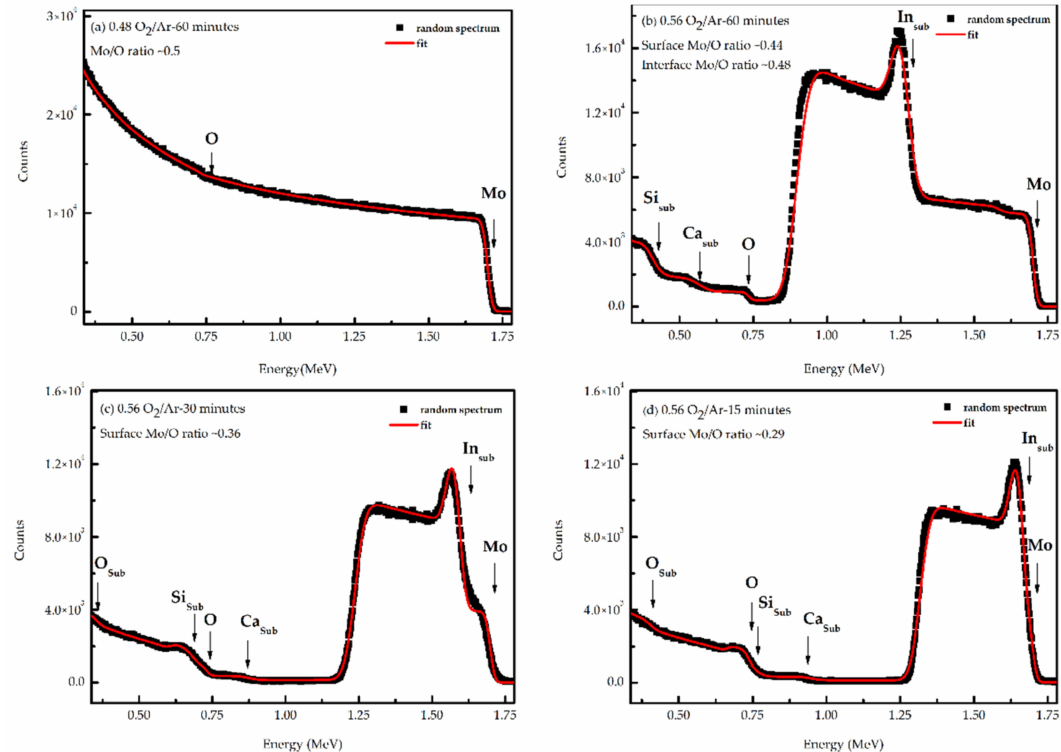
Figure 2. Rutherford Backscattering Spectrometry (RBS) spectrum obtained for measurements of the last sample from the first series: ( a ) deposited with a flow rate ratio of 0.48 O 2 /Ar for 60 min; and of the samples of the second series, prepared with the same flow rate ratio of 0.56 O 2 /Ar and different deposition times, ( b ) 60 min, ( c ) 30 min and ( d ) 15 min. The vertical arrows correspond to the surface/interface scattering energies of the different elements assigned to the film/substrate